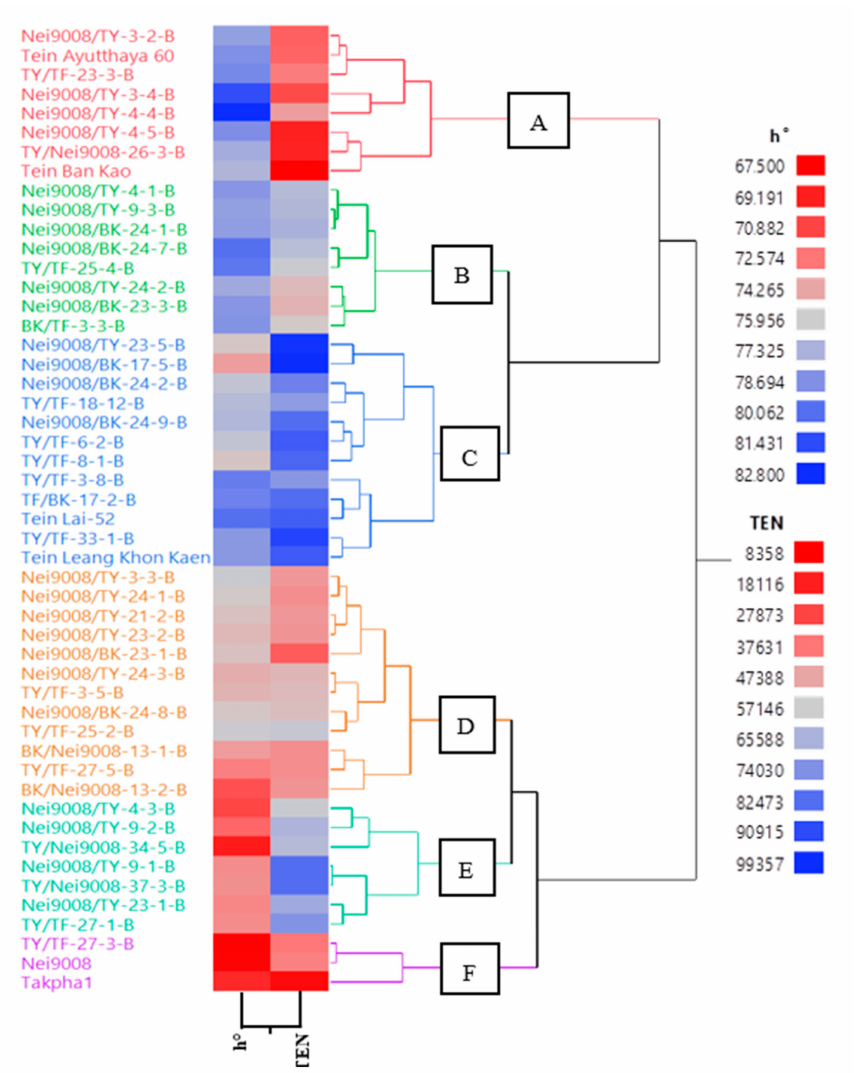
Figure 3. Dendrogram of phenotypic relationships among 50 small-ear waxy corn varieties. Six main clusters ( A – F ) were formed. Two-way Ward’s cluster analysis based on color parameter (h ◦ ) and total ear number